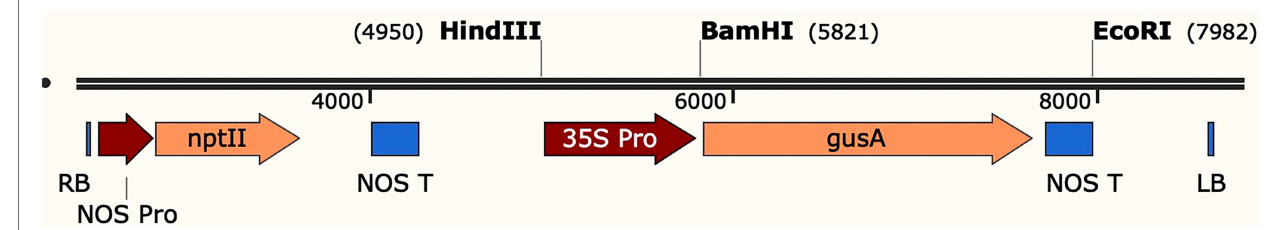
FIGURE 1 | Schematic diagram of the T-DNA region in the plasmid pBI121- GUS . RB, right border; LB, left border; NOS-Pro, promoter sequences of the nopaline synthase gene; nptII : neomycin phosphotransferase II gene; NOS-T: nopaline synthase terminator; HindIII = unique HindIII restriction site within T-DNA; BamHI = unique BamHI restriction site within T-DNA; EcoRI = unique EcoRI restriction site within T-DNA; 35S-Pro, cauliflower mosaic virus 35S promoter; gus A , coding region of the GUS